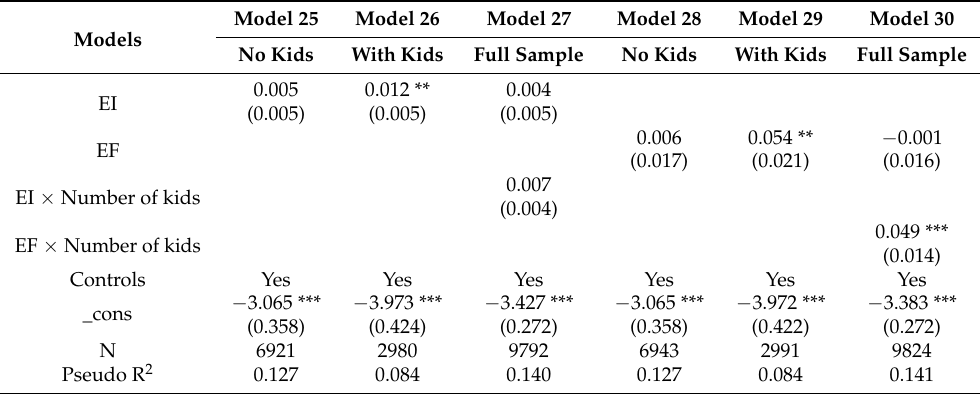
Table 6. Comparison of having minor children or